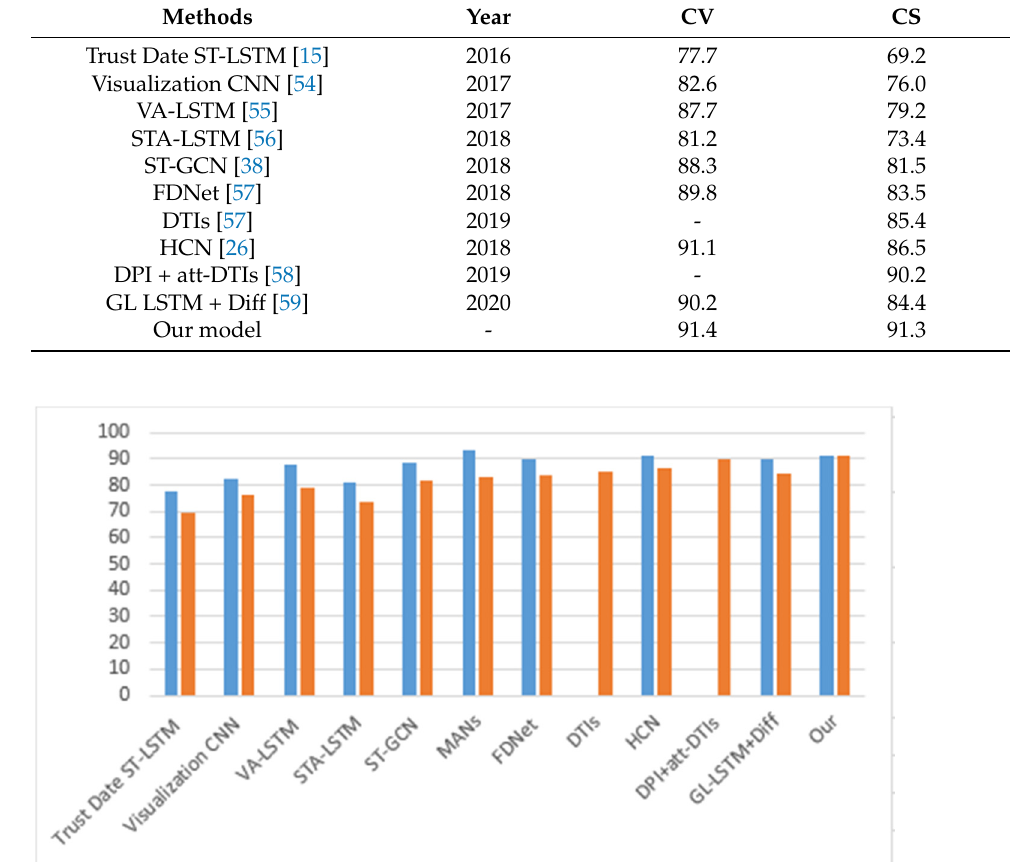
Figure 6. Accuracy comparisons for cross-subject (CS) evaluation for different methods using the SYSU dataset. 5.5. Comparison with State-of-the-Art Methods We conducted a systematic evaluation of the various models using the datasets men- tioned above. The proposed approach showed improved accuracy (Tables 3–7). 1.